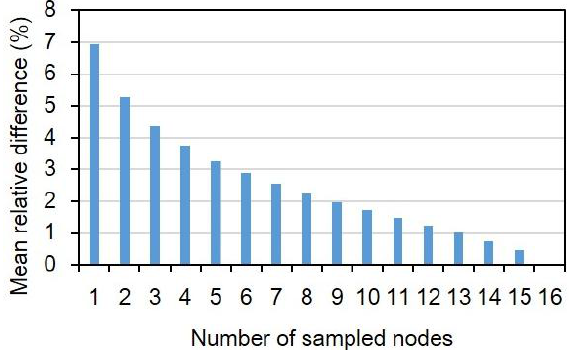
Figure 11. The mean relative difference of all possible combinations when different numbers of nodes are